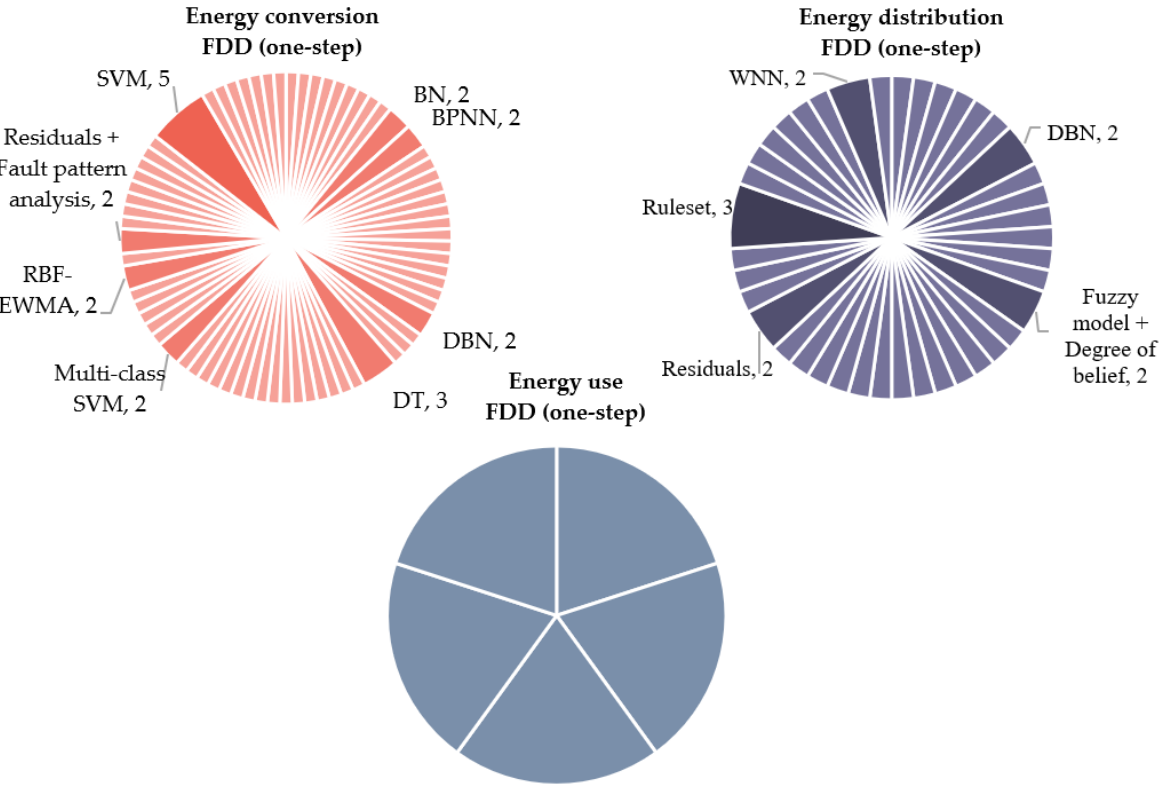
Figure 14. Energy-conversion, energy-distribution, and energy-use EST groups for one-step FDD.